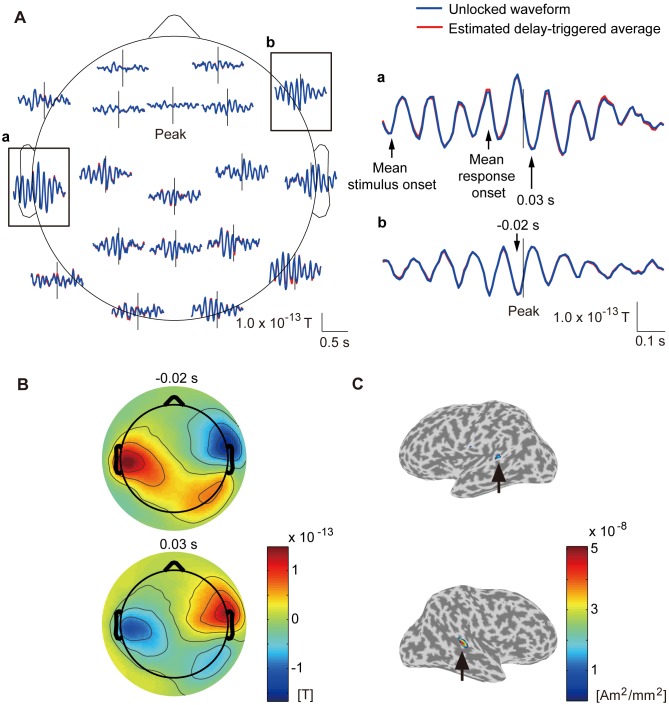
Unlocked waveform (subject 8).
A: Time course of unlocked waveform. Blue and red lines represent unlocked waveform and estimated delay-triggered average. Vertical lines represent peak time of unlocked waveform. Framed plots are enlarged on the right (a and b). B: Spatial patterns of unlocked waveform at −0.02 s (upper) and 0.03 s (lower) after peak of unlocked waveform. C: Current sources estimated from unlocked waveform. Powers averaged across time from −0.25 s to 0.25 s after peak of unlocked waveform are shown. Other subjects show similar results.